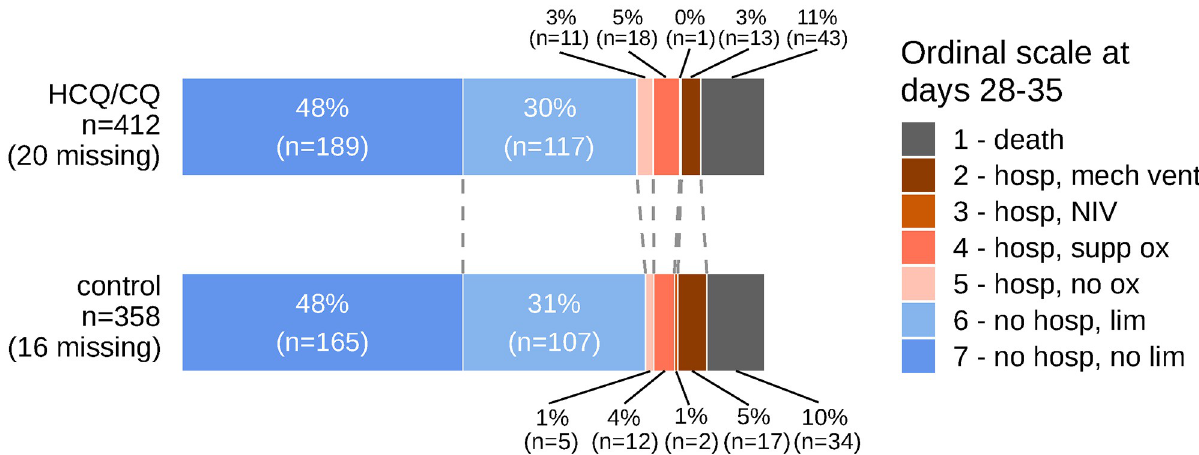
Fig 2. Primary outcome data by treatment group. Scores were defined as: (1) death; (2) hospitalized, on mechanical ventilation or ECMO; (3) hospitalized, on non-invasive ventilation (BiPAP/CPAP and/or high-flow oxygen); (4) hospitalized, requiring oxygen; (5) hospitalized, not requiring oxygen; (6) not hospitalized, with limitation; and (7) not hospitalized, without limitations. Abbreviations: HCQ/CQ, hydroxychloroquine or chloroquine; NIV, noninvasive